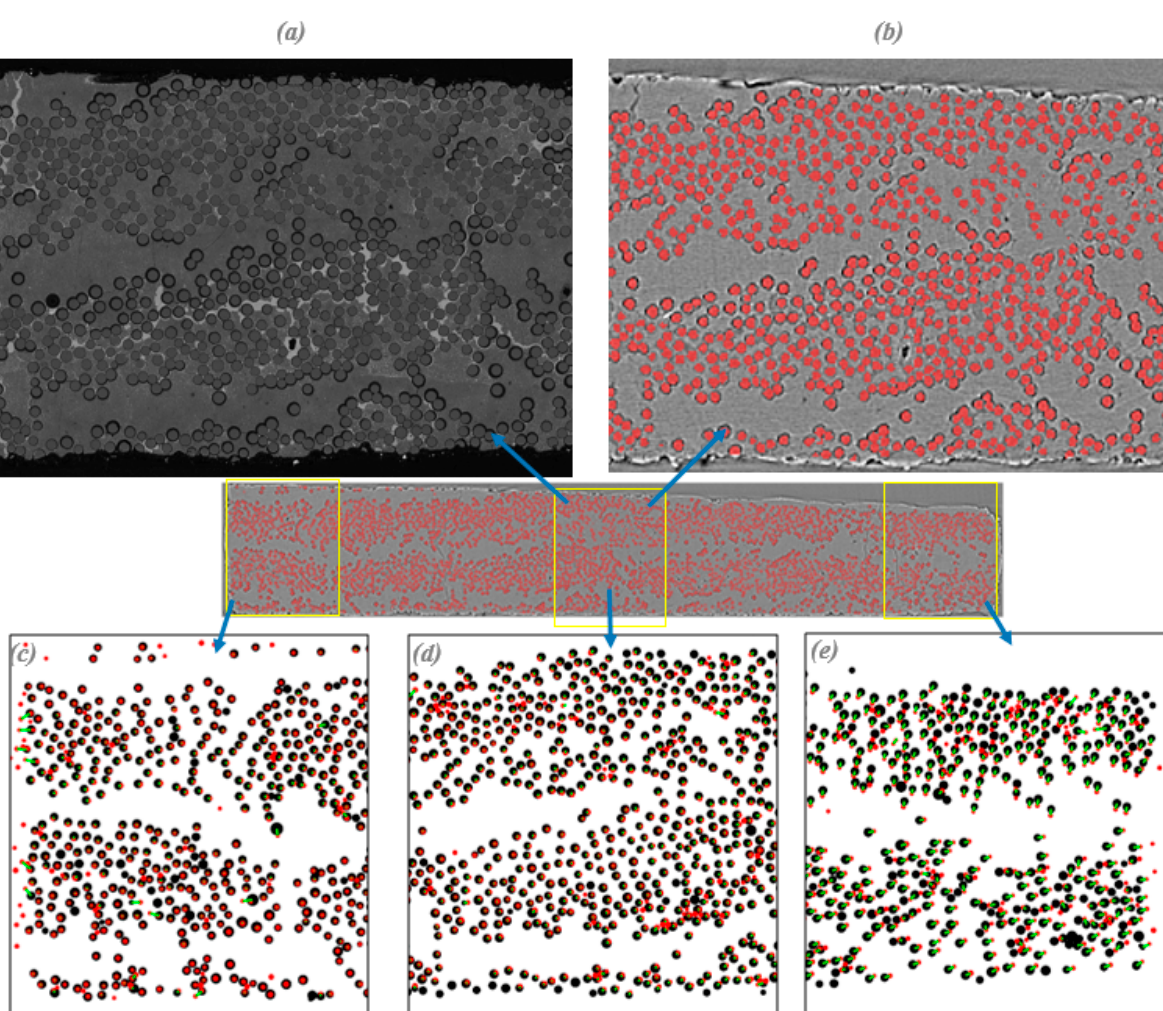
Figure 4. Comparisons of segmented fibers with optical image of an area within Figure 1a. ( a ) Optical image. ( b ) Superposition of optical image in ( a ) with fiber segmentation mask derived from CT image of the same area. ( c – e ) Superposition of fiber segmentation masks derived from optical image (black) and CT image slice (red). Green lines connect corresponding fibers in the two masks (the correlation allowed a tolerance up to 7 µm to account for possible misalignment between the optical and CT images).